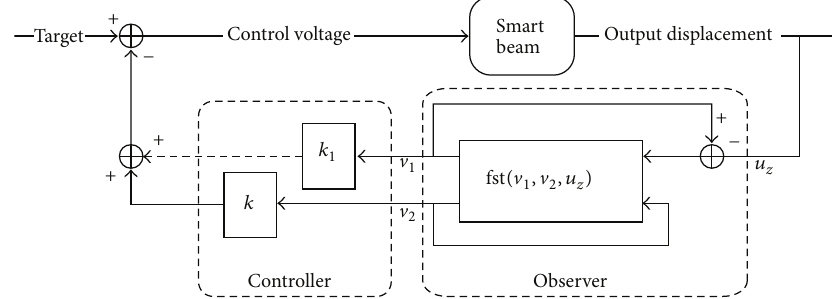
Figure 3: Control block.